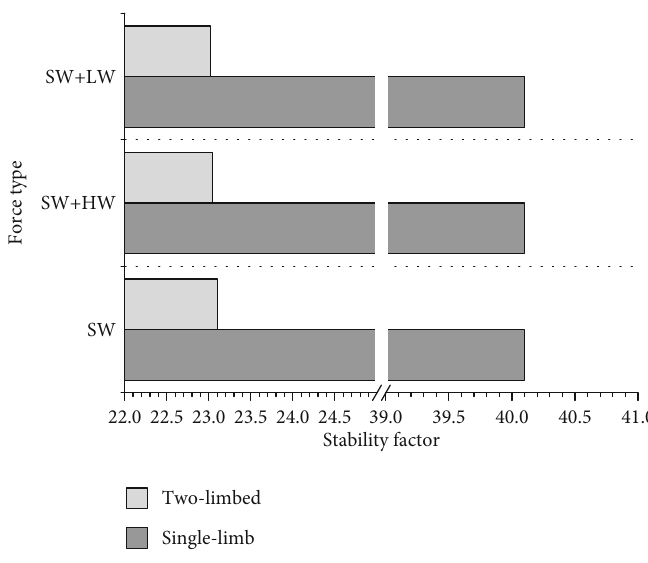
Figure 7: Stability coe ffi cient of bridge pier under SW +LW/HW.